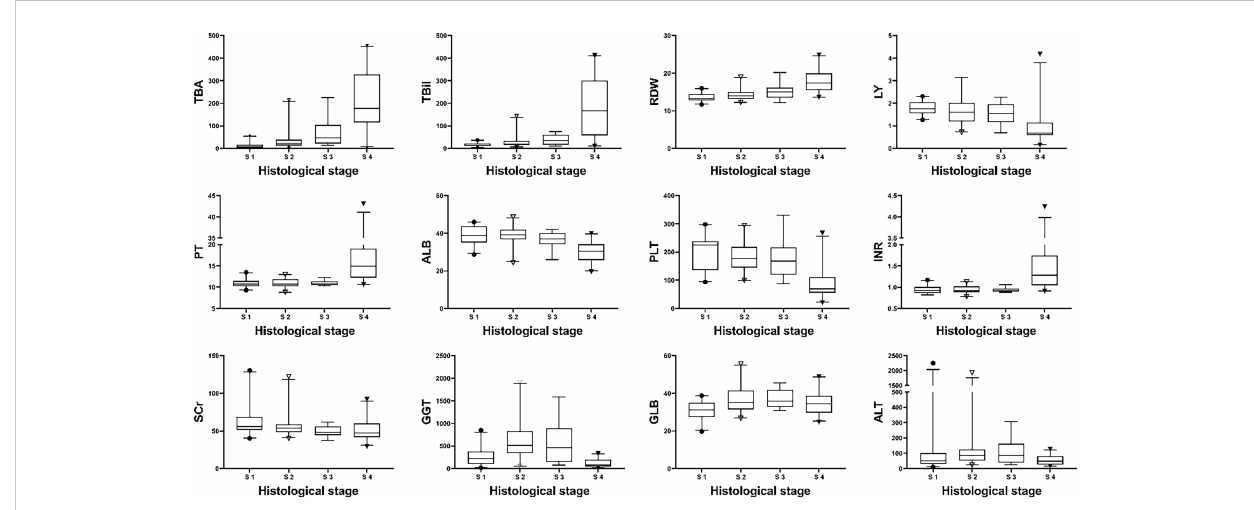
FIGURE 1 Distribution of biochemical parameters with histological stages in the model group. Note: The top and bottom of each box are the 25th and 75th percentiles, the horizontal line through the box is the median, and the error bars are the 5% and 95%